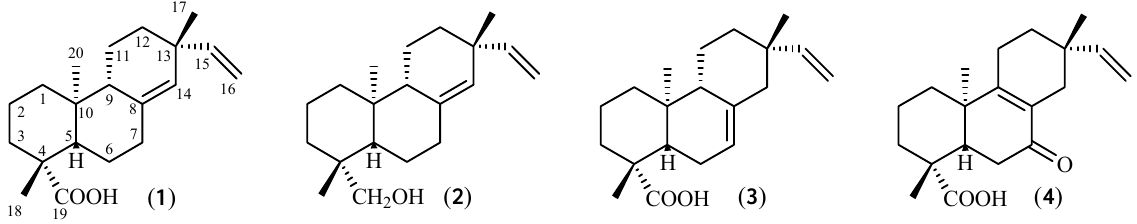
Figure 1. Chemical structures of PA ( 1 ) and its derivatives obtained by microbial transformation with G. cingulata (compound 2 ) and M. rouxii (compounds 3 and 4